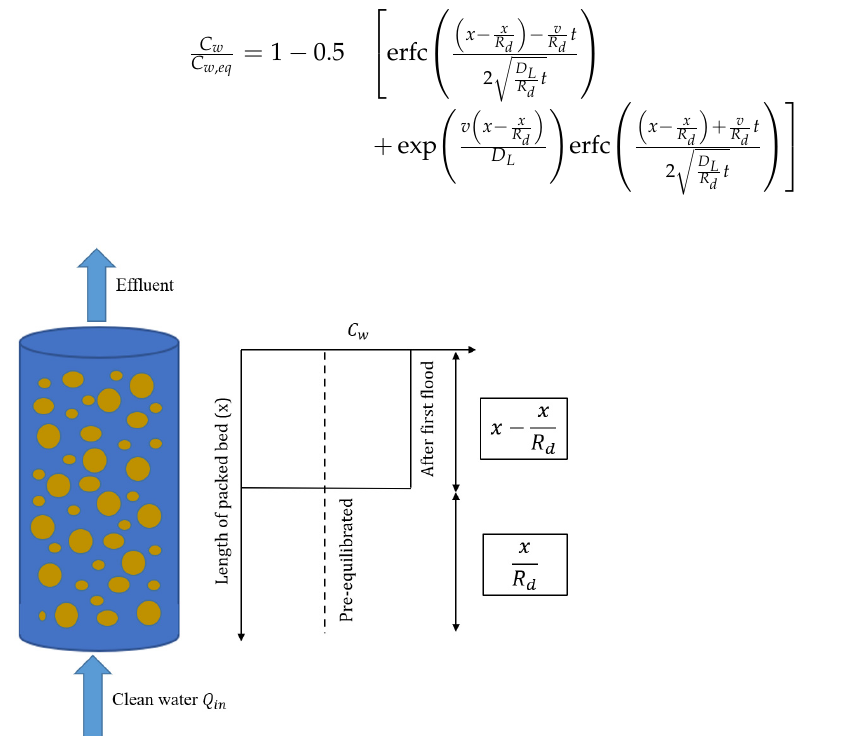
Figure 1. Initial concentration distribution in a column of length 𝑥 for the “pre-equilibrated” case (dashed line) and after the first flooding of an initially dry column from the bottom (solid line); no dispersion, 𝑅 (cid:3031) = 2 , after Grathwohl and Susset, 2009 [21].